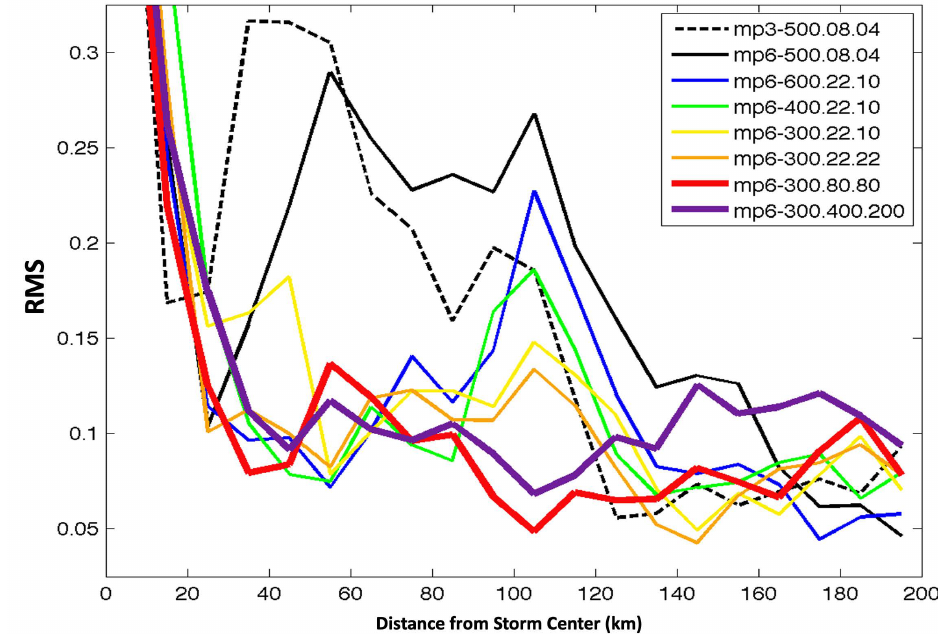
Figure 15. The Root Mean Square (RMS) difference as computed based on the analyses of the data in Figures 13 and